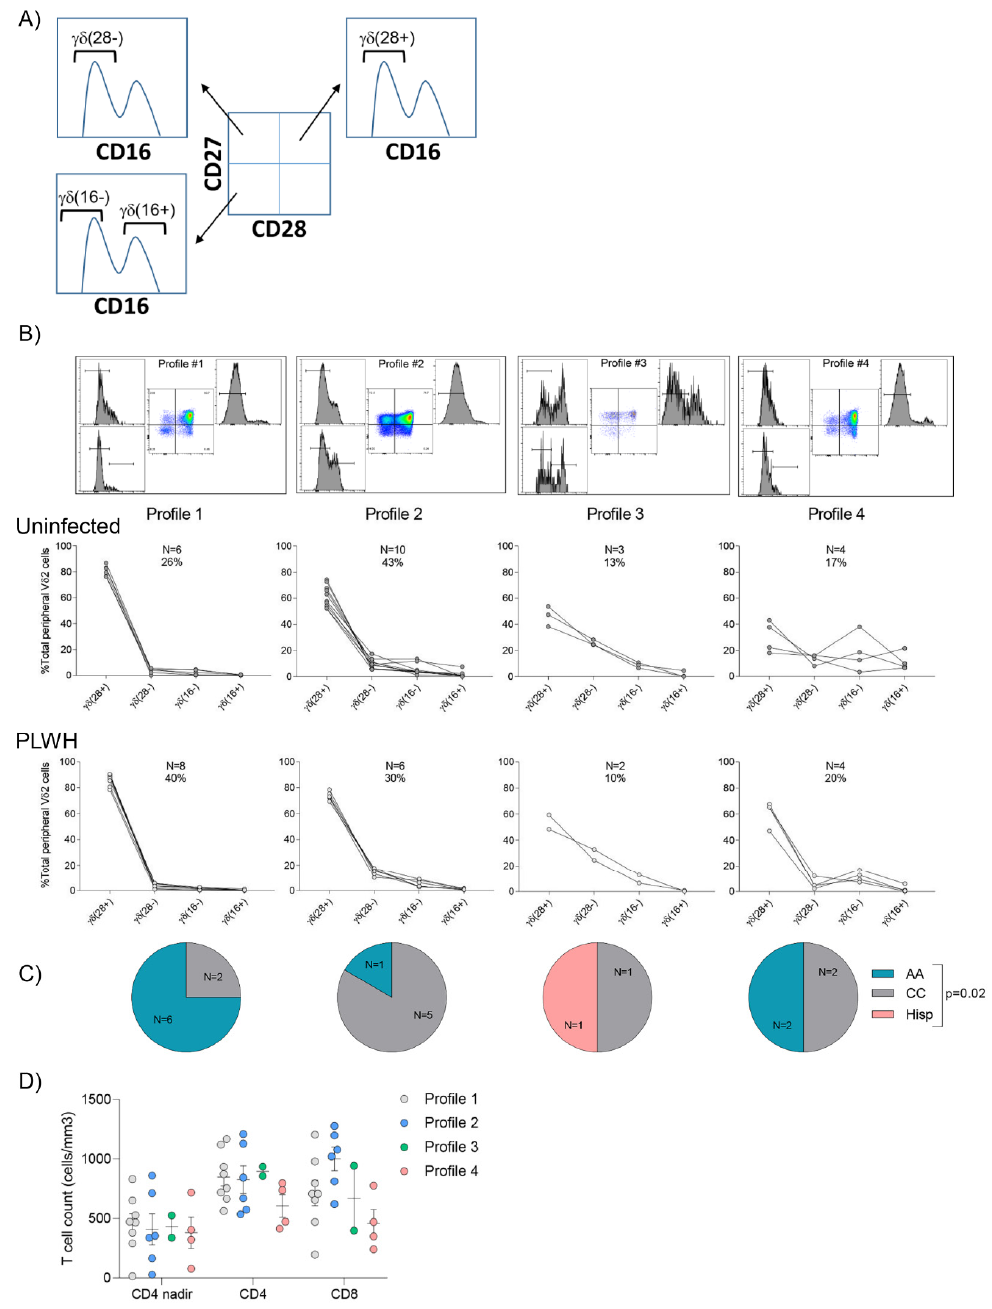
Figure 3. Classification of individuals according to the frequency of V δ 2 cell populations. Based on the classification of ( A ) four distinct V δ 2 populations ( γδ (28 + ) , γδ (28 − ) , γδ (16 − ) , and γδ (16 + ) , individuals were grouped into four distinct profiles both in ( B ) Uninfected (N = 23, top pseudocolor plots showing representative plots of V δ 2 profile distribution, and top graphs) and PLWH (N = 20, bottom graphs). ( C ) Racial distribution within each profile amongst PLWH: African American (AA), Caucasian (CC), Hispanic (Hisp) ( p = 0.02, Fisher exact test). ( D ) Classification of PLWH into the di ff erent profiles according to the frequency of nadir CD4 T cell count, CD4 T cell count and CD8 T cell count (cells / mm 3 ) at the time of the visit ( p = 0.95, p = 0.28 and p = 0.07, respectively, Kruskal-Wallis rank sum